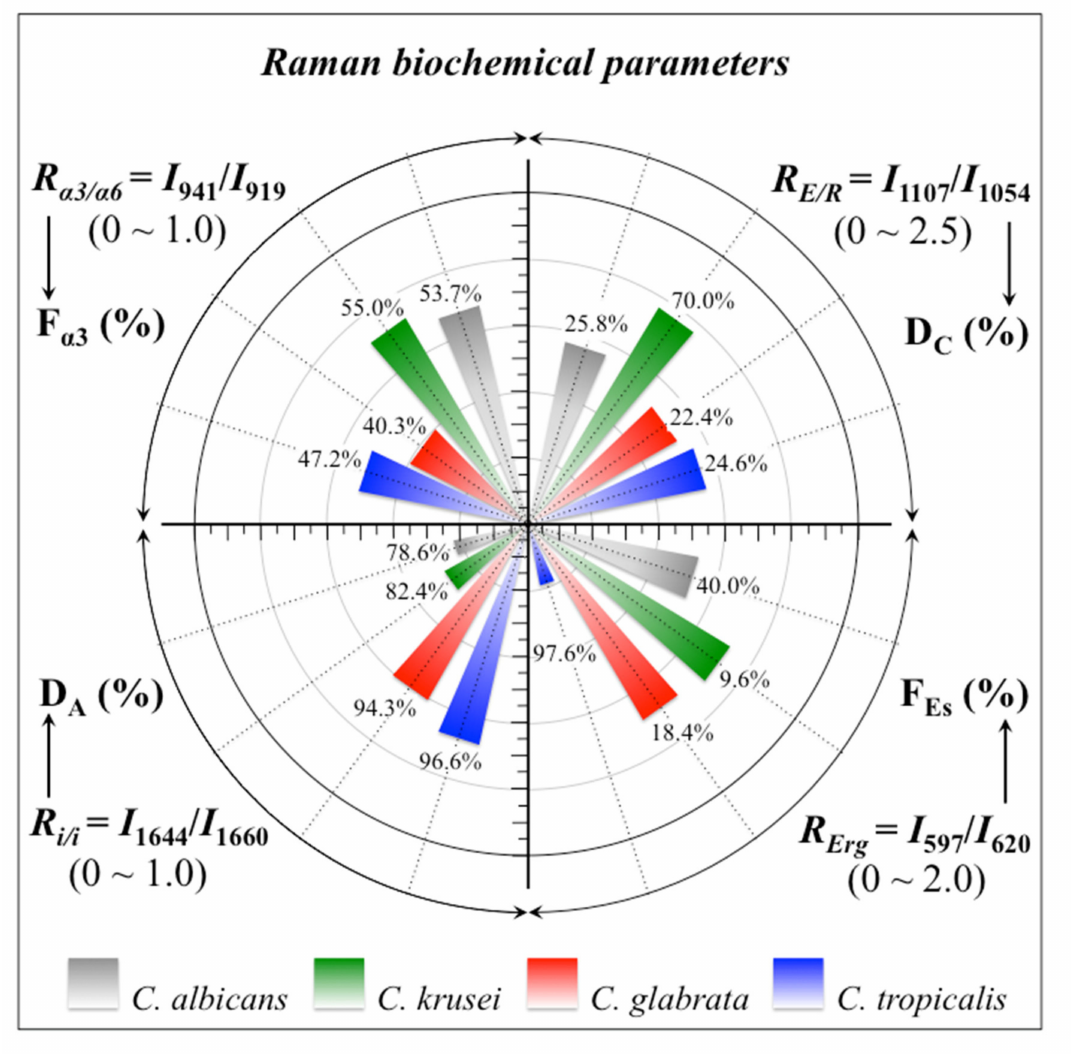
Figure 8. Polar plot of four selected Raman biochemical parameters for the studies Candida species: R α 3/ α 6 = I 941 / I 919 , R E/R = I 1107 / I 1054 , R i/i = I 1644 / I 1660 , and R Erg = I 597 / I 620 , quantitatively linked to